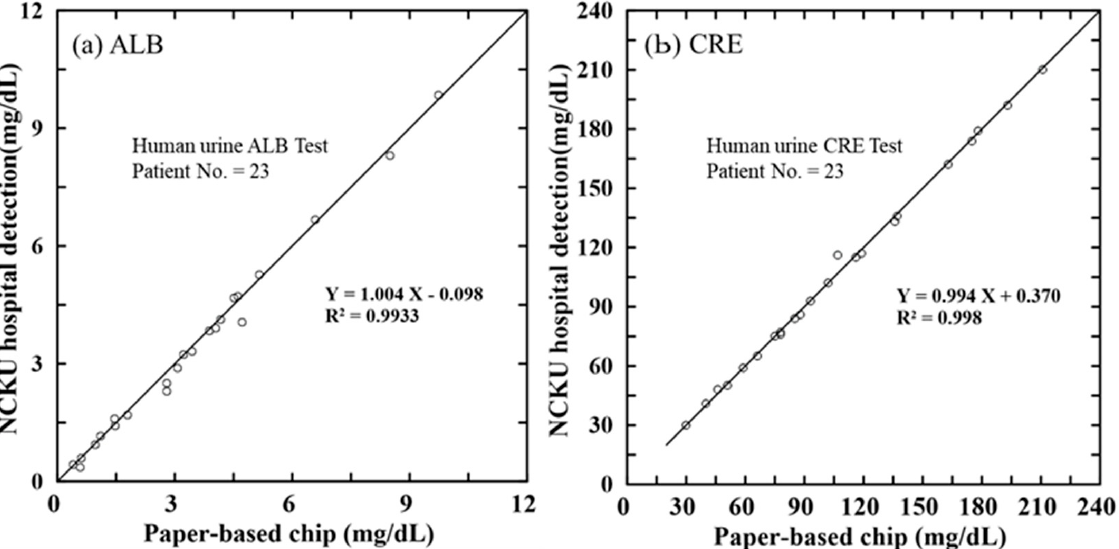
Figure 7. Comparison of benchtop results and paper-based chip results for: ( a ) ALB concentration and ( b ) CRE concentration of real-world urine samples. Table 2. Comparison of several properties between the current platform detection system and the developed methods for ALB and CRE detection in urine samples.